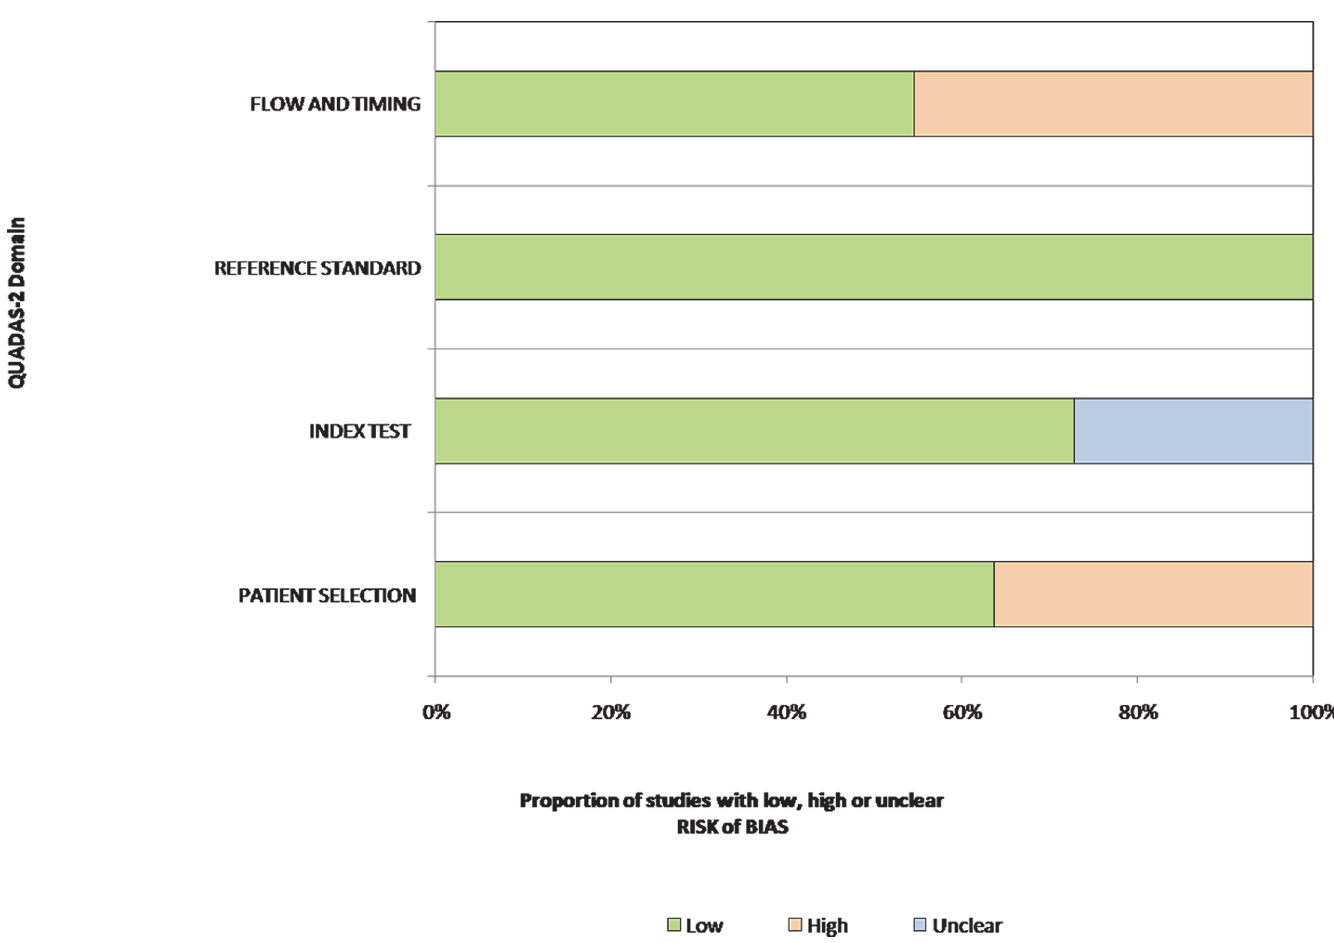
Fig 2. Graphical display for QUADAS-2 results regarding proportion of studies with high, low or unclear risk level of bias. Results showed that a considerable risk of bias existed in flow and timing, which was mainly caused by different reference standard and unclear time intervals between index test and reference